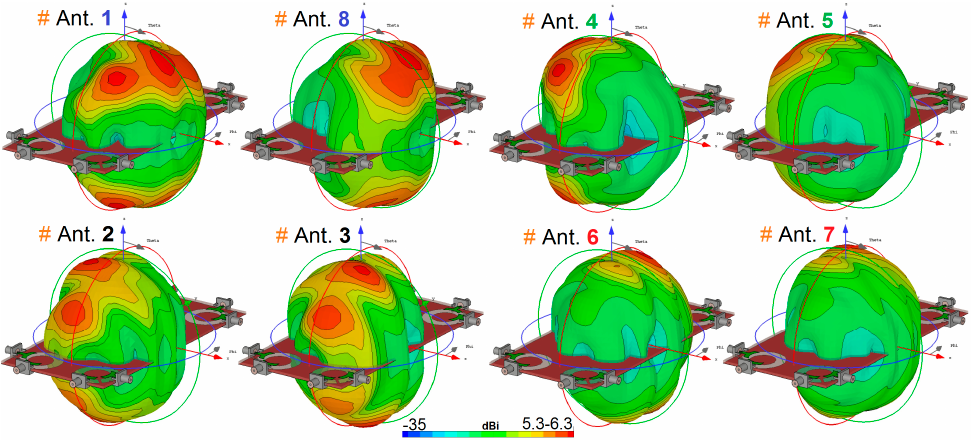
Figure 19. Radiation patterns of the diversity antenna element with directivity value at 5.5 GHz.